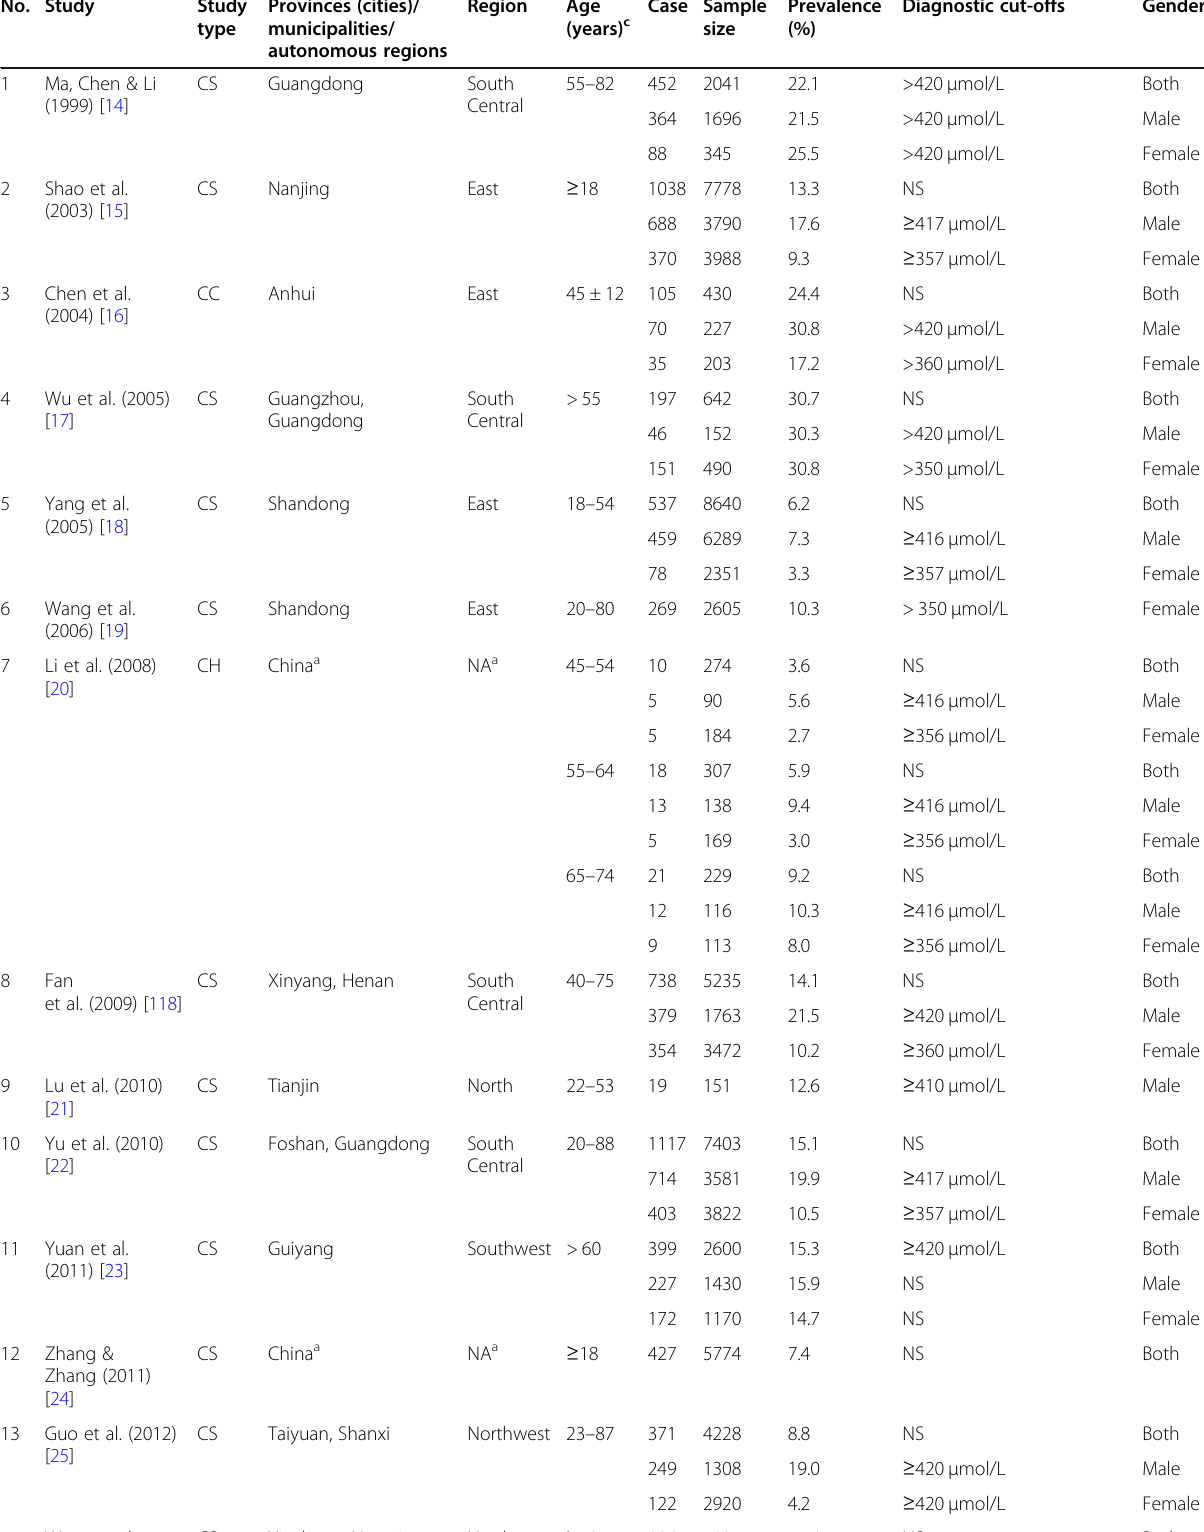
Table 1 Characteristics of the included studies in the systematic review and meta-analysis No.